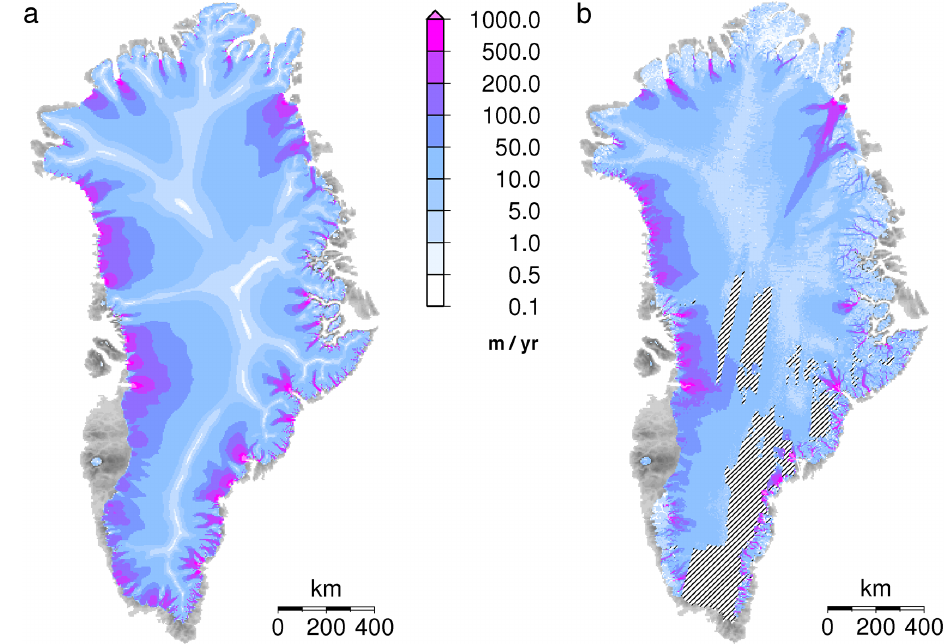
Figure 6. Comparison of present-day modelled (a) and observed (b) surface velocities. Observations are averaged over the years 2000 and 2005–2008 (Joughin et al.,